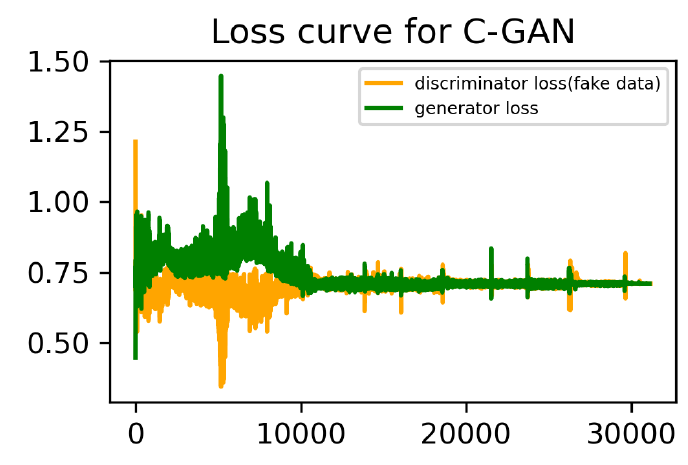
Figure 2: C-GAN loss